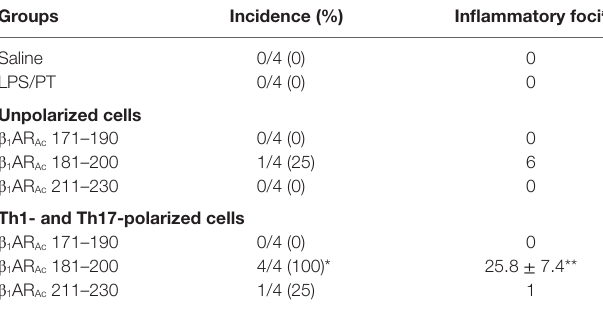
a Represents mean ± SEM values derived from myocarditic animals. *P < 0.05 vs. control groups. **P < 0.01 vs. control